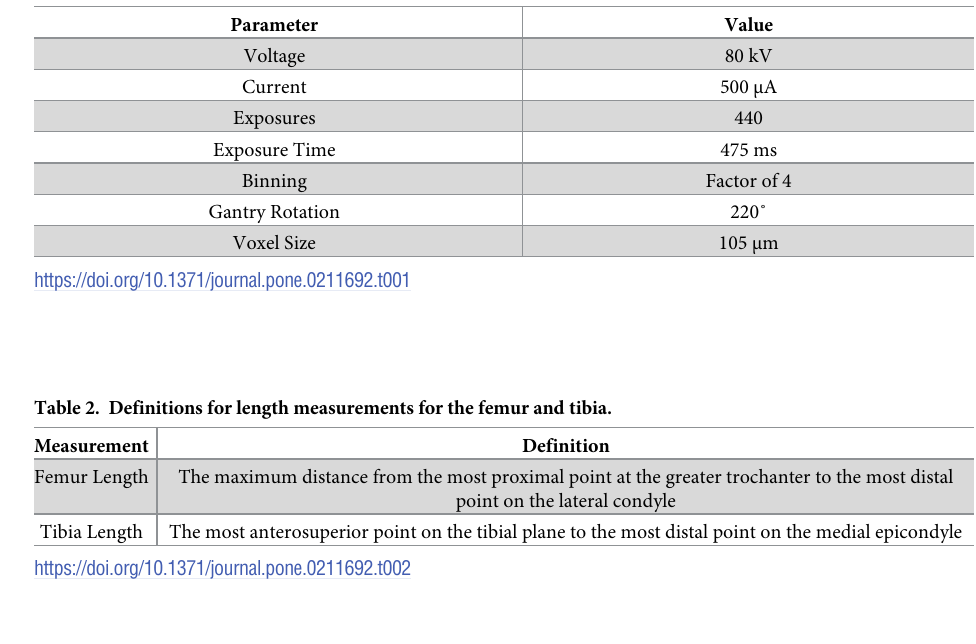
Table 1. μ CT scan parameters used in this